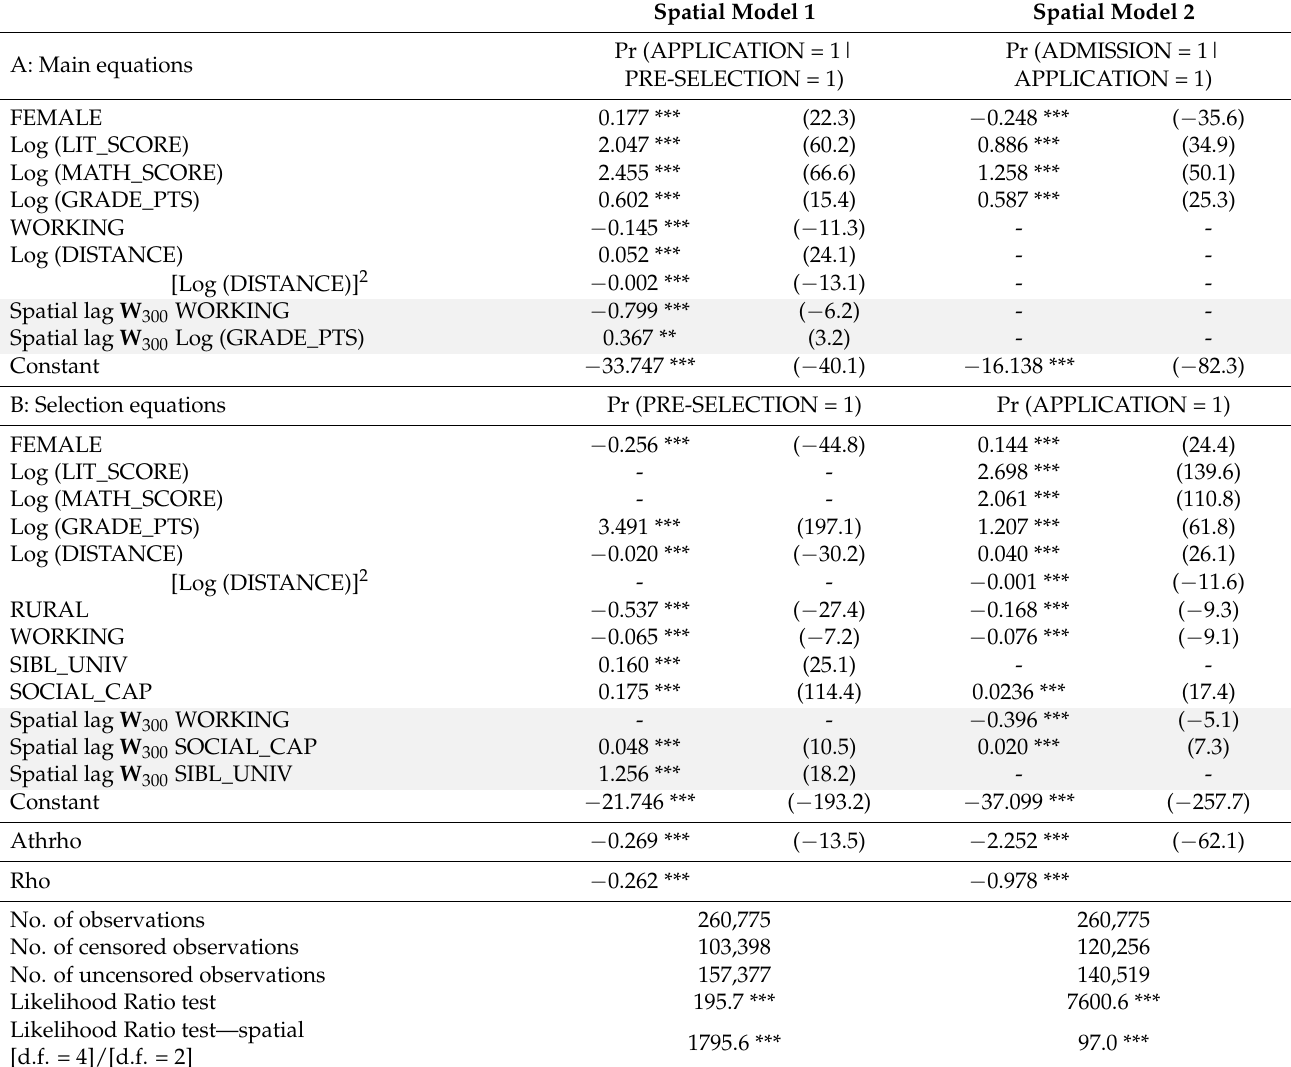
Table 4. Estimated coefficients of the spatial Heckman probit